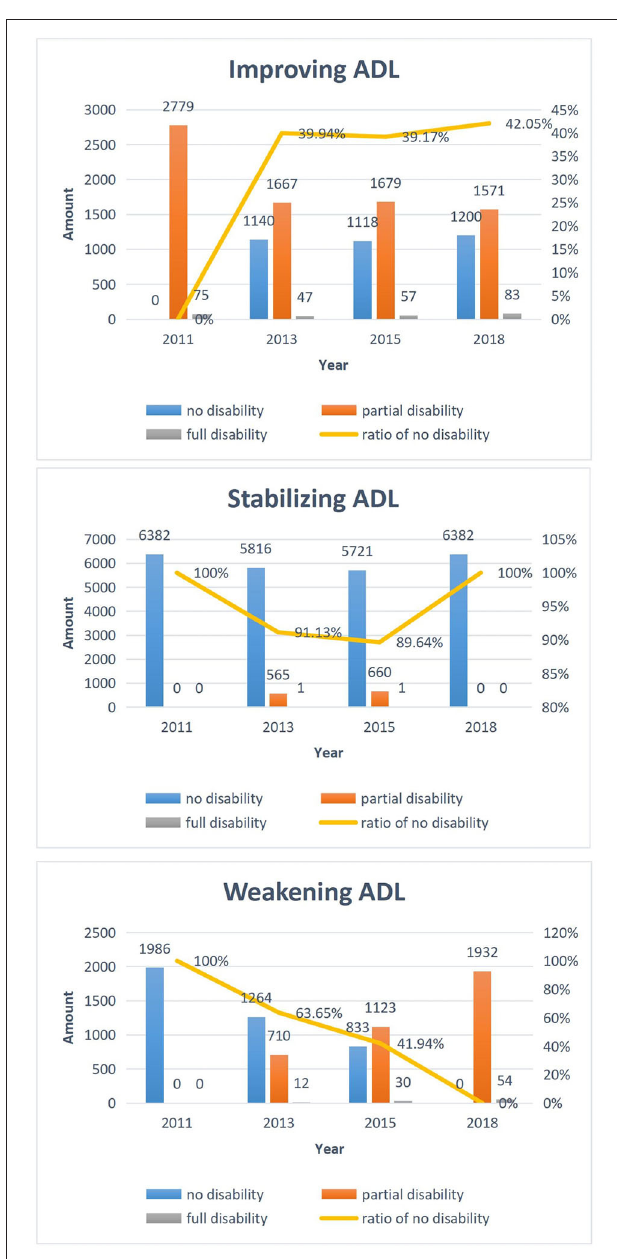
FIGURE 2 | Three classes of ADL trends and their composition of disability condition in four